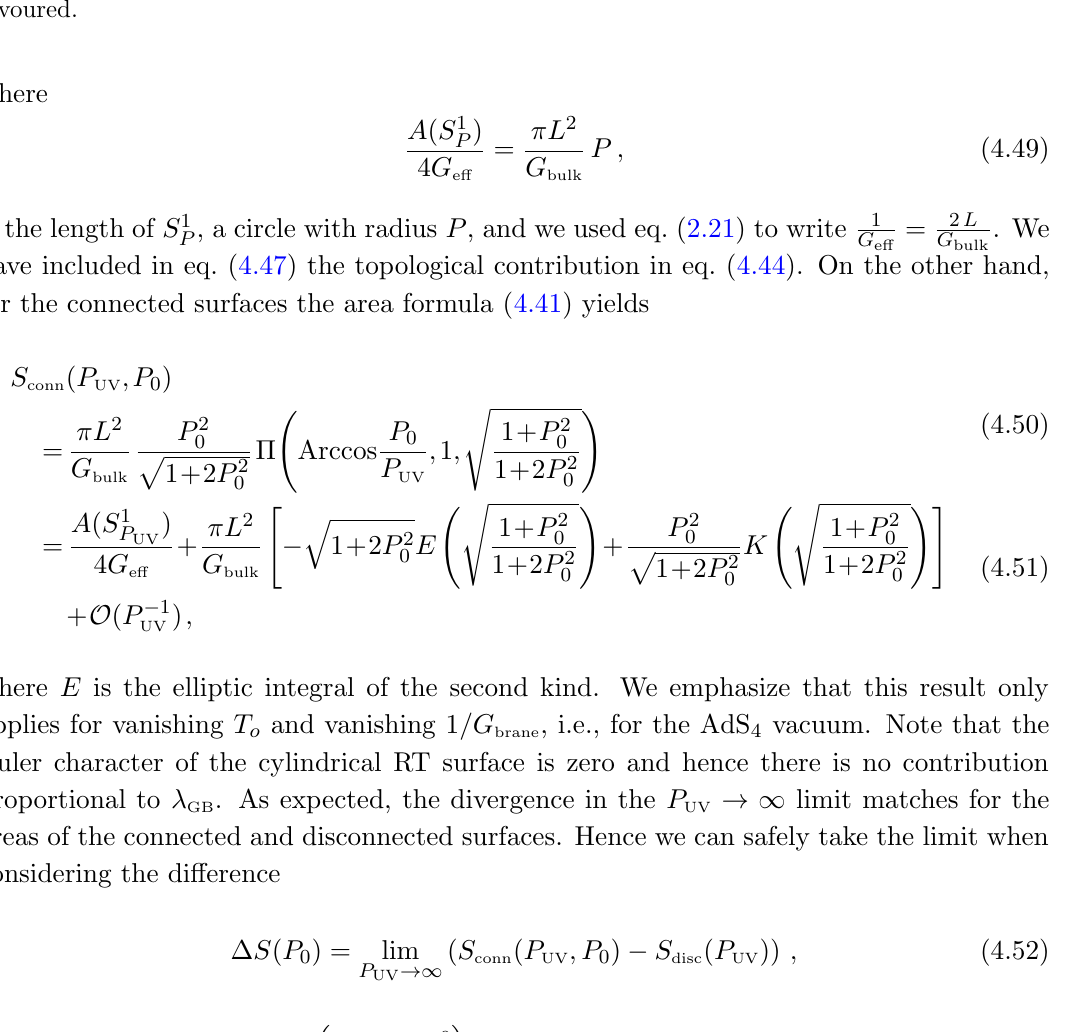
becomes very large, (cid:21) GB